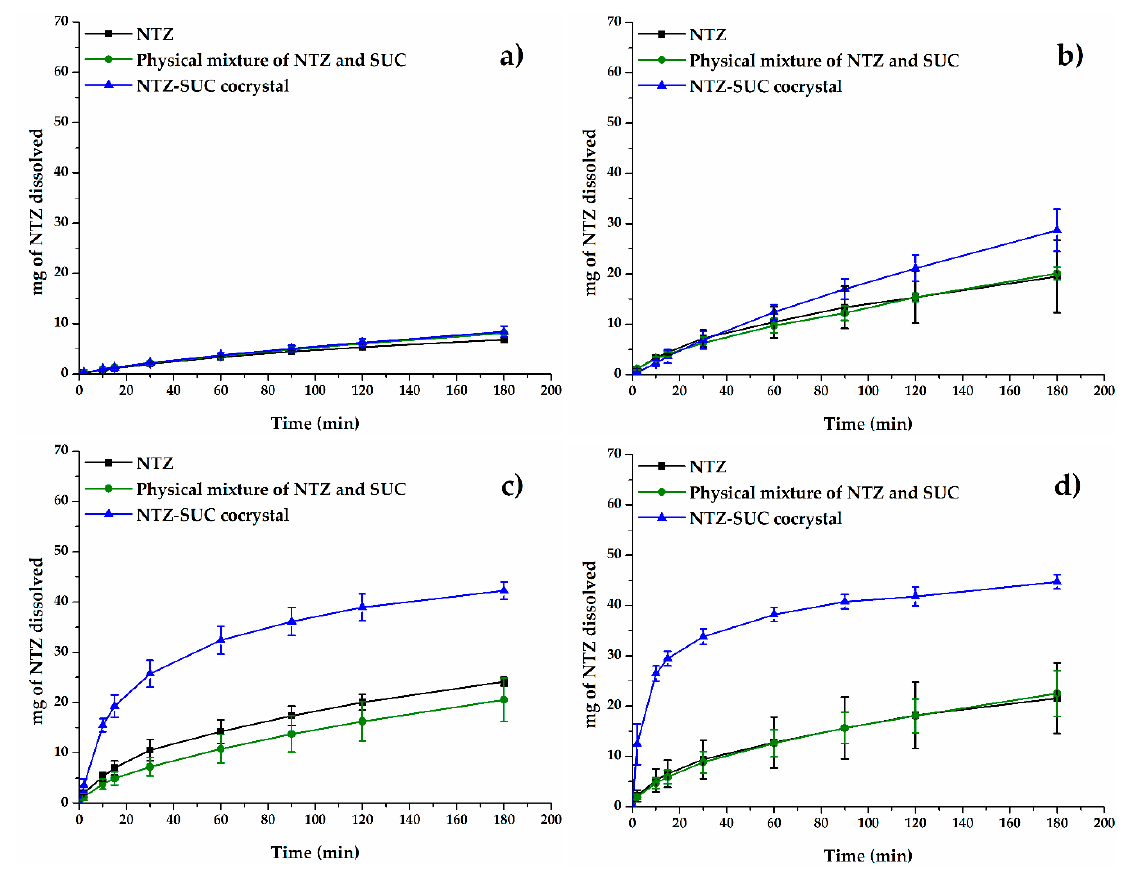
Figure 6. Powder dissolution profiles (in pH 7.5 PBS at 37 ± 0.5 °C) for pure NTZ, the 2:1 stoichiometric physical mixture of NTZ and SUC, and NTZ-SUC (2:1) cocrystal formulated with Methocel ® 60 HG ( w / w ): ( a ) 0.0%; ( b ) 1.0%; ( c ) 2.5%; ( d ) 5.0% ( n = 3 ± SD).